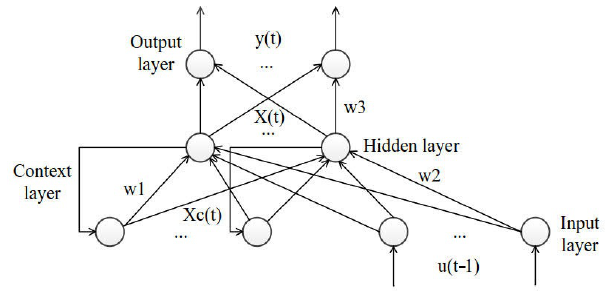
Figure 3. The structure of Elman Neural